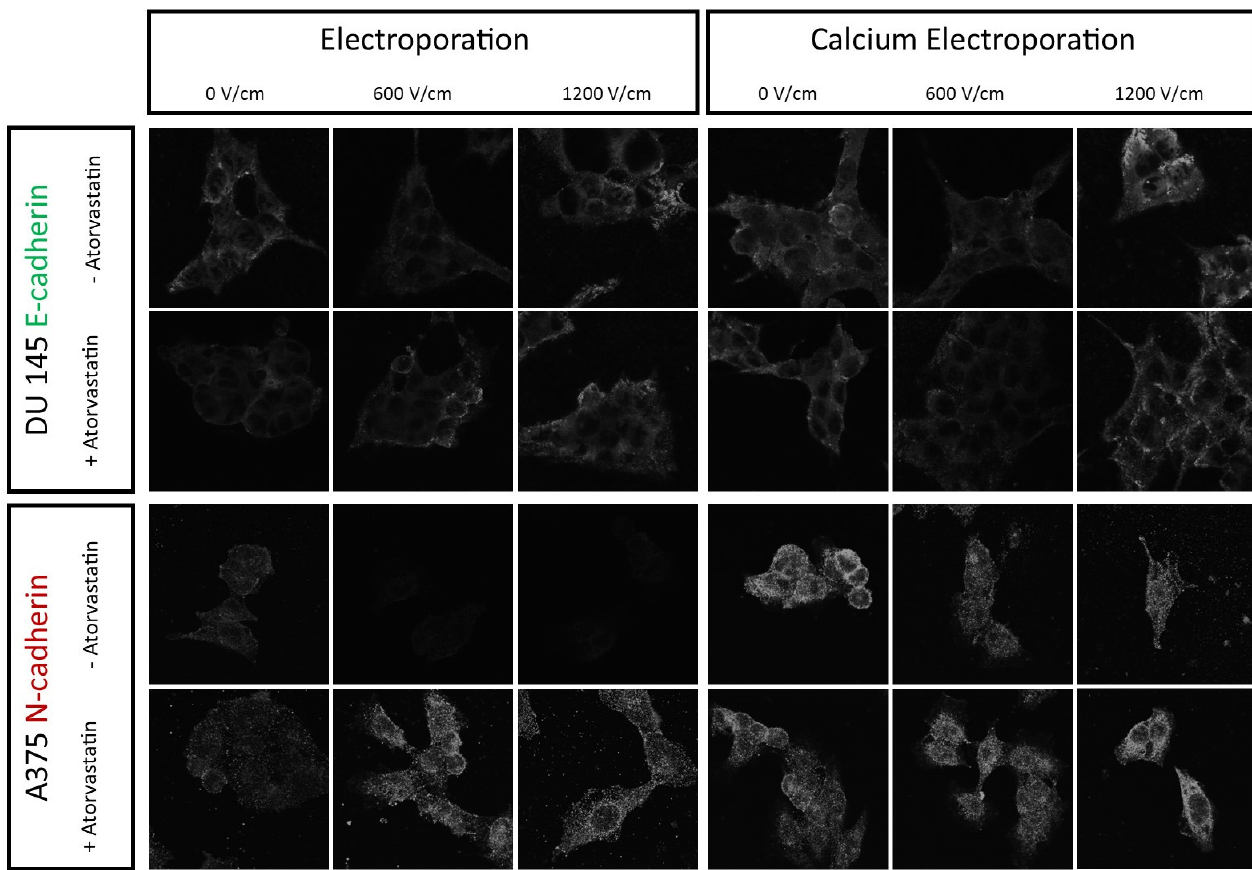
Figure 8. Confocal laser microscopy studies of E- and N-cadherins expression in the DU 145 and A375 cells after the atorvastatin-aided 5 mM calcium ECT. The layout is divided vertically into two sections—PEF treatment and CaEP. Further, each of them is vertically divided into three PEF intensities (0, 600, and 1200 V/cm). Each cell line is grouped and within each, the higher row shows cells not treated with atorvastatin and the lower one shows the cells preincubated for 48 h with the drug. Cells within one parameter were separately labeled with first order anti-N-cadherin or anti-E-cadherin antibody and then with second order Alexa 488 conjugated antibody. Samples were observed under Olympus F1000 confocal laser microscope, oil immersion lens with 60 × magnification, NA: 1.35 was used to observe the